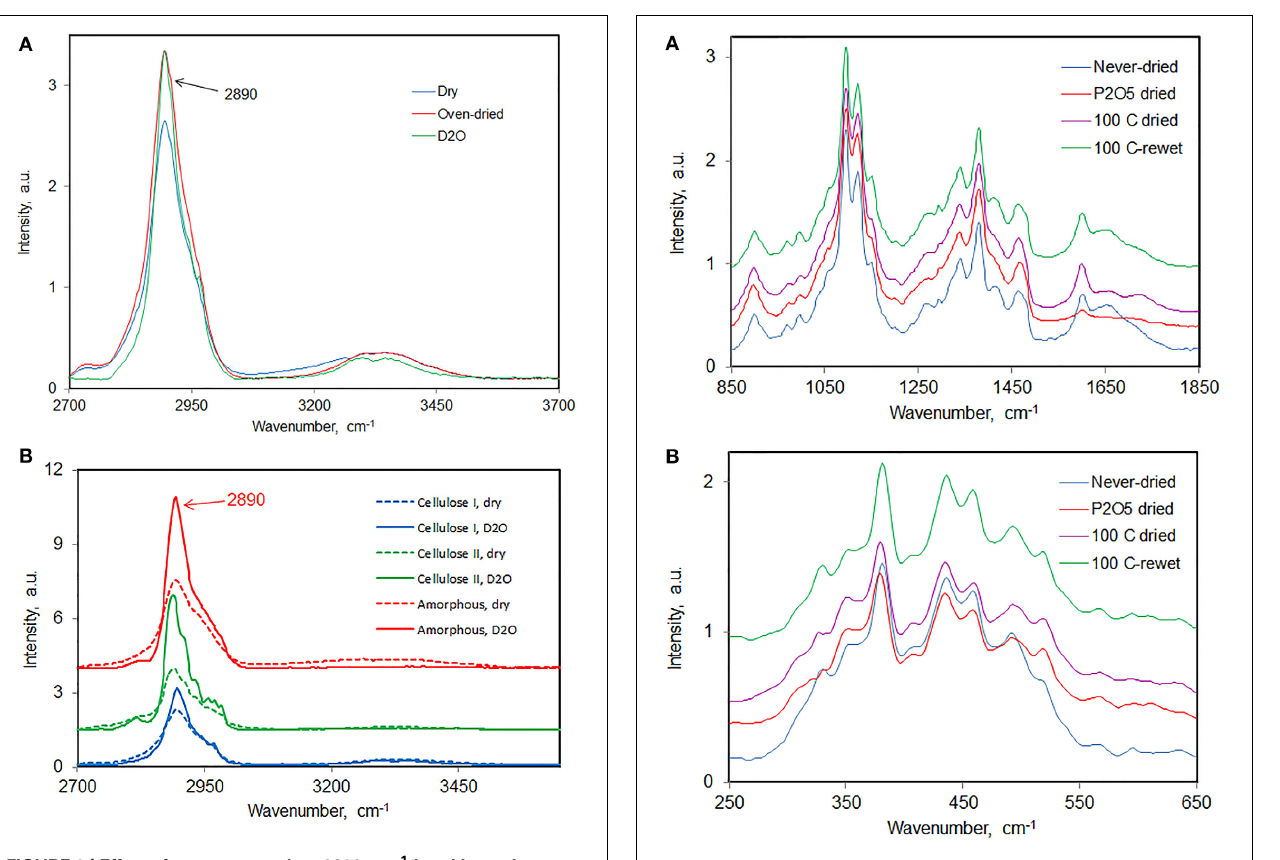
FIGURE 10 | Raman spectra of Jack pine holocellulose in never-dried, dried, and dried-then-rewet states; (A) 850–1850cm − 1 , (B) 250–650cm − 1